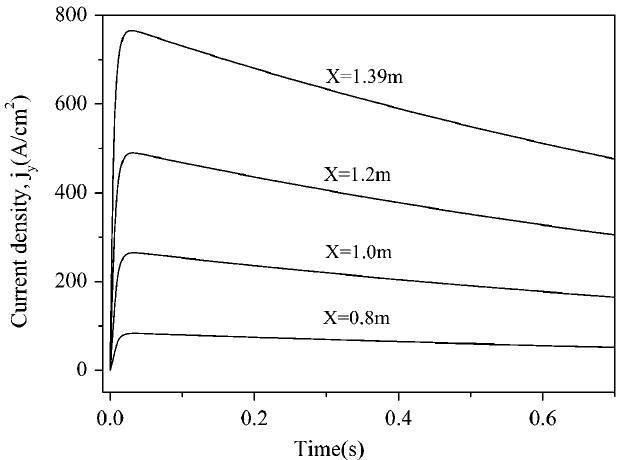
FIG. 10. Time variation of the current density at various points ( X ¼ 0 : 8 , 1.0, 1.2, and 1.39 m from the edge) of a plate of dimension ð 1 : 4 ; 1 : 4 ; 0 : 002 Þ m 3 when exposed to an exponentially time decaying field.